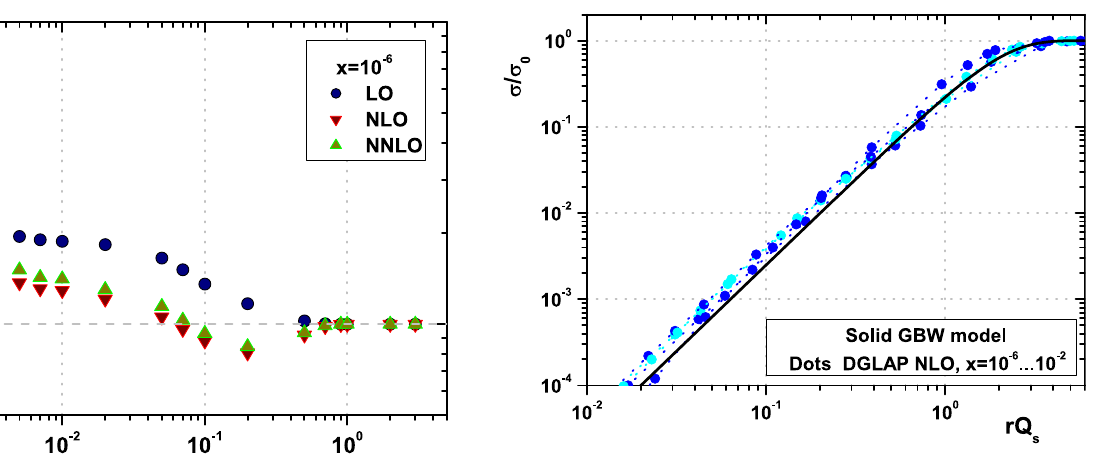
Fig. 5 The extracted ratio σ dip ( rQ s ( x ))/σ 0 as a function rQ s for x = 10 − 6 ... 10 − 2 fromtheparameterizationof F 2 withintheLOapprox- imation(circleanddotcurves)mergesintoonelineduetothegeometric scaling and compared with the GBW model (solid curve)